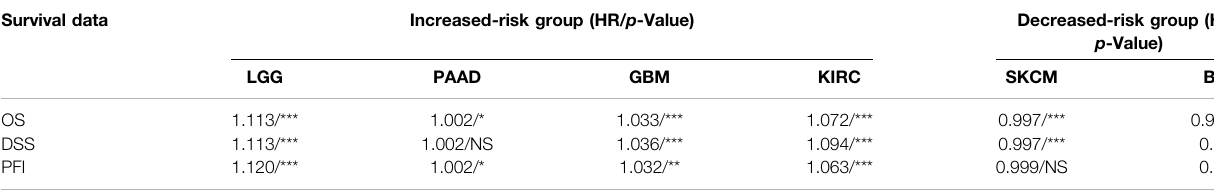
TABLE 1 | Univariate Cox analysis of the correlation between KCNN4 expression level and survival indicators. Survival data